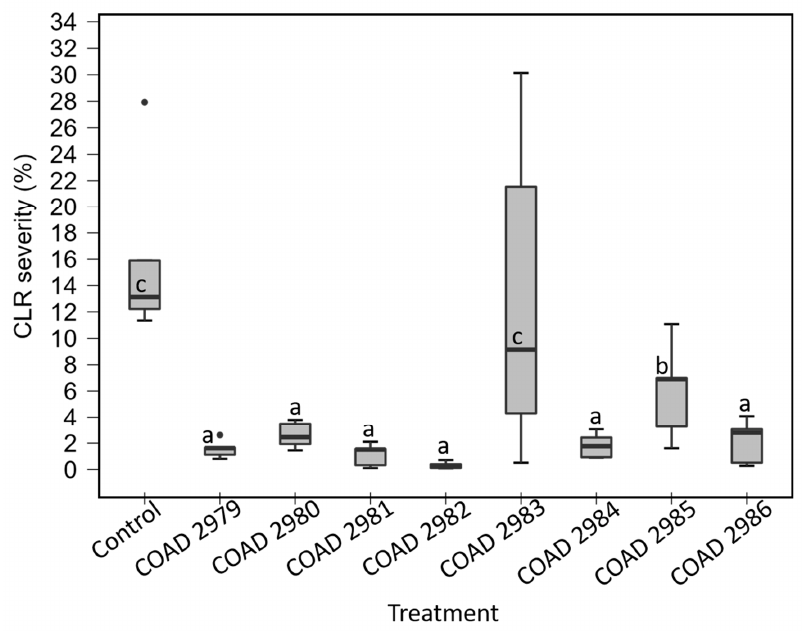
Figure 6. Same as above for experiment II. Each mean value is the result of five replicates; means followed by the same letter do not differ significantly (Dunnett, p < 0.05). Thus, all isolates of Clonostachys were able to endophytically colonize C. arabica tissues (Table 3), and only COAD 2983 ( C. byssicola ) did not reduce the CLR severity in both experiments (Figures 5 and 6). The evidence of Clonostachys spp. reducing the severity of CLR is shown in Figure 7.